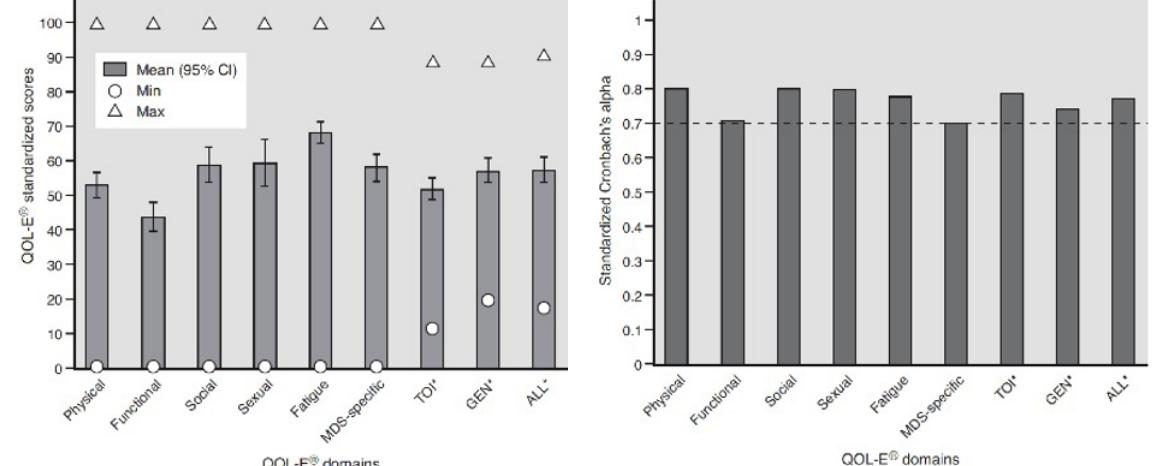
Figure 2A. Distribution and reliability of QOL-E® V2.0 in 147 MDS patients Distribution of standardized QOL-E® scores